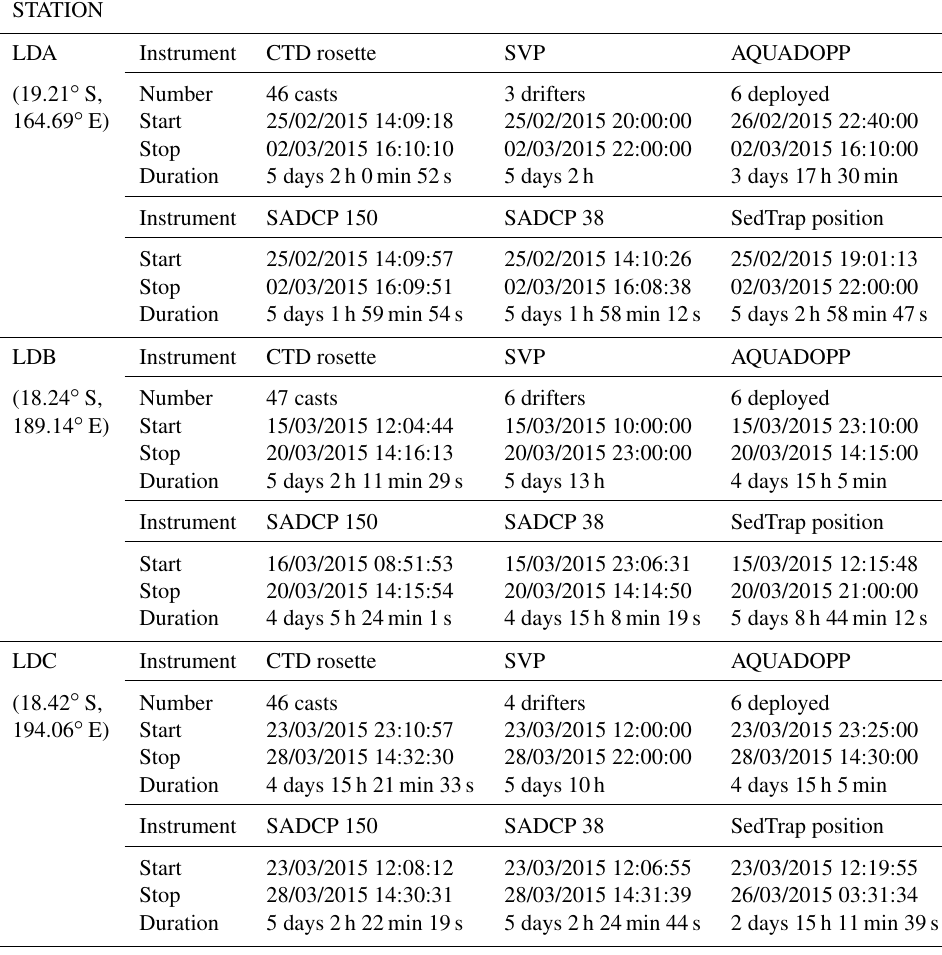
Table 1. Start and stop times for the time series data in each LD station of OUTPACE. Times expressed in DD/MM/YYYY HH:MM:SS (GMT) format. When multiple instruments were deployed or multiple discrete observations made, this is also